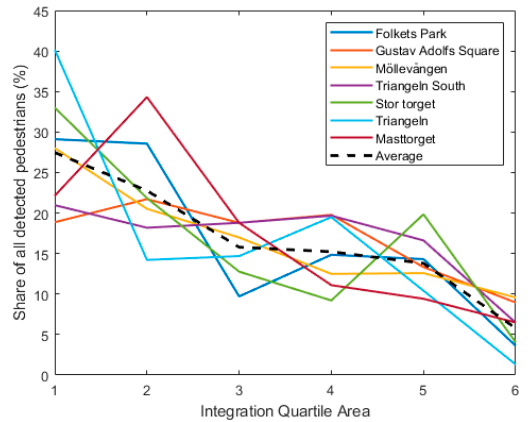
Figure 10. The relationship between integration level and the share of pedestrian detections using six integration